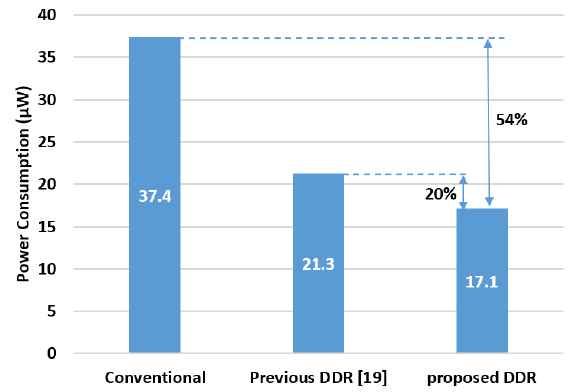
Figure 26. Power consumption of the proposed DDR counter compared with conventional structures.